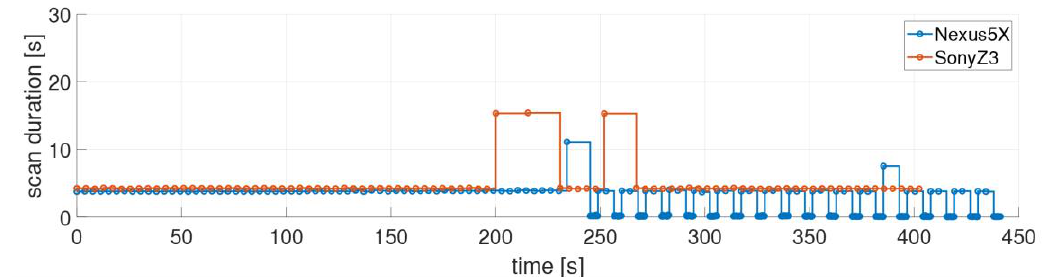
Figure 11. Irregular scan durations of the two smartphones Nexus 5X and Sony Z3. The short scan durations of the Nexus 5X are shown in Figure 12 together with the measured signal strengths. Again the results of the 5 GHz signal of the same AP as in Figure 3 are presented. As shown in Figure 12a, the irregular scanning periods start between the checkpoints 6 and 7. The pattern is always similar as first slightly longer scan duration occurs followed by a series of scans with a short scan duration, whereby the total duration of these scans corresponds to the average scan duration. After that, two scans occur with average scan duration and then a series of short scans starts again. A